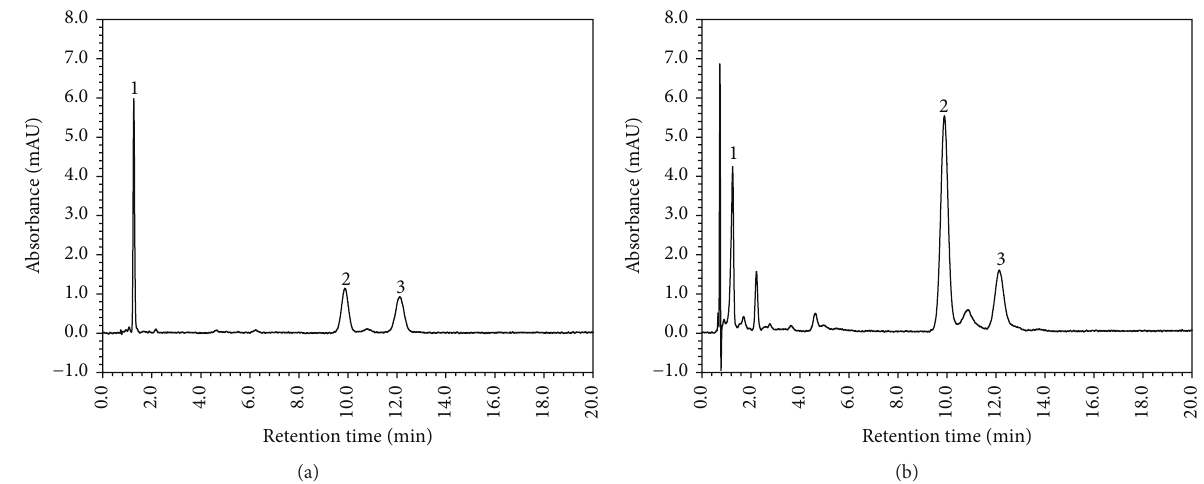
Figure 1: High performance liquid chromatography (HPLC) chromatogram of carotenoid standards (a) and tomato sample; Betatniy (b). Peak identification 1: lutein; 2: lycopene; and 3: 𝛽